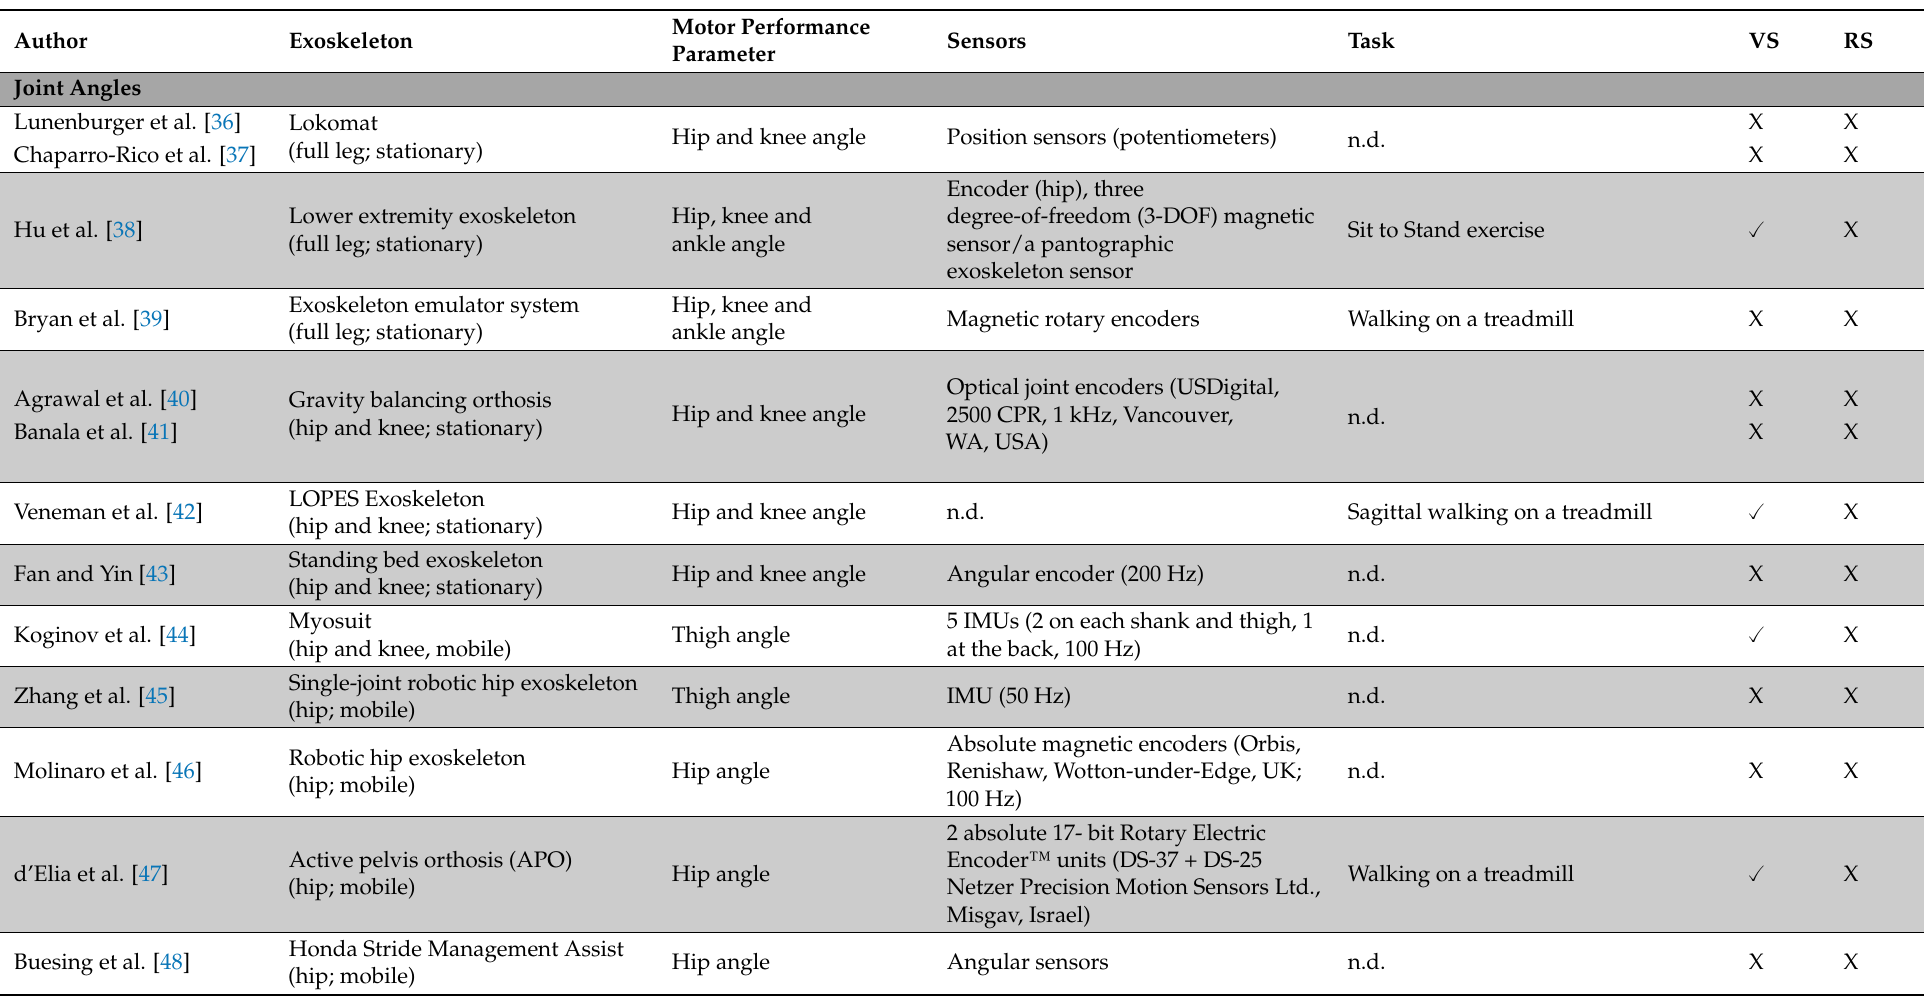
Table 1. Overview and brief description of included studies (Abbreviations: 6MWT, 6-min walk test; CPR, counts per revolution; FSR, Force Sensing Resistor; IMU, Inertial Measurement Unit; n.d., not described; RS, reliability study; VS, validity